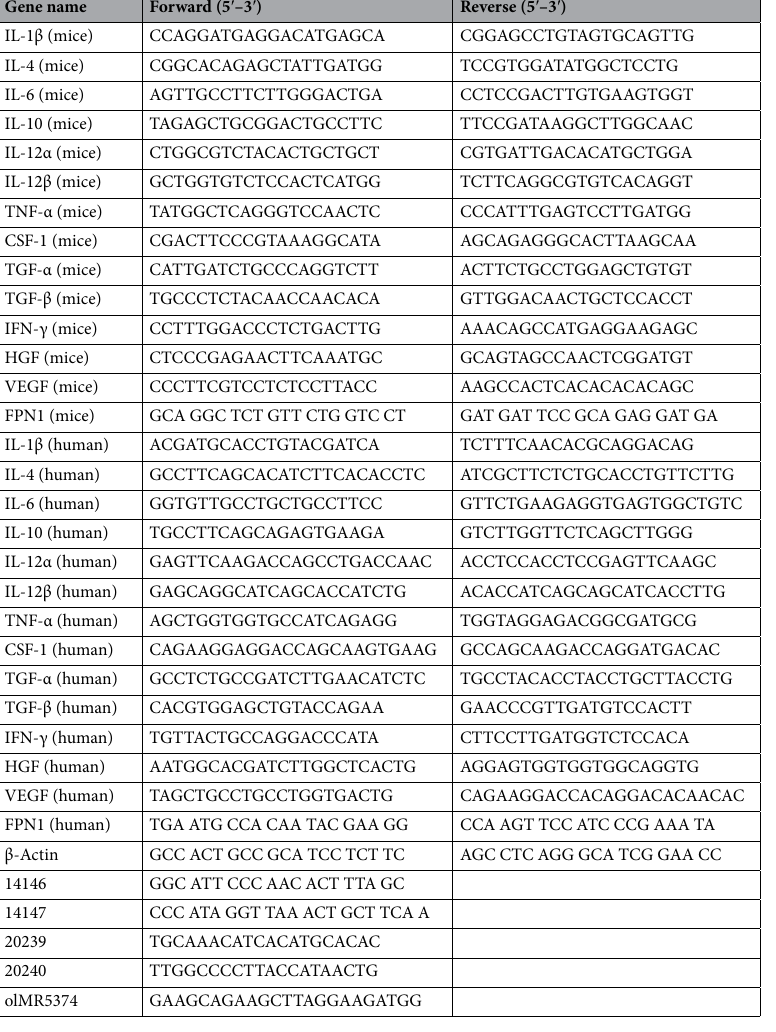
Table 1. List of the sequence of gene